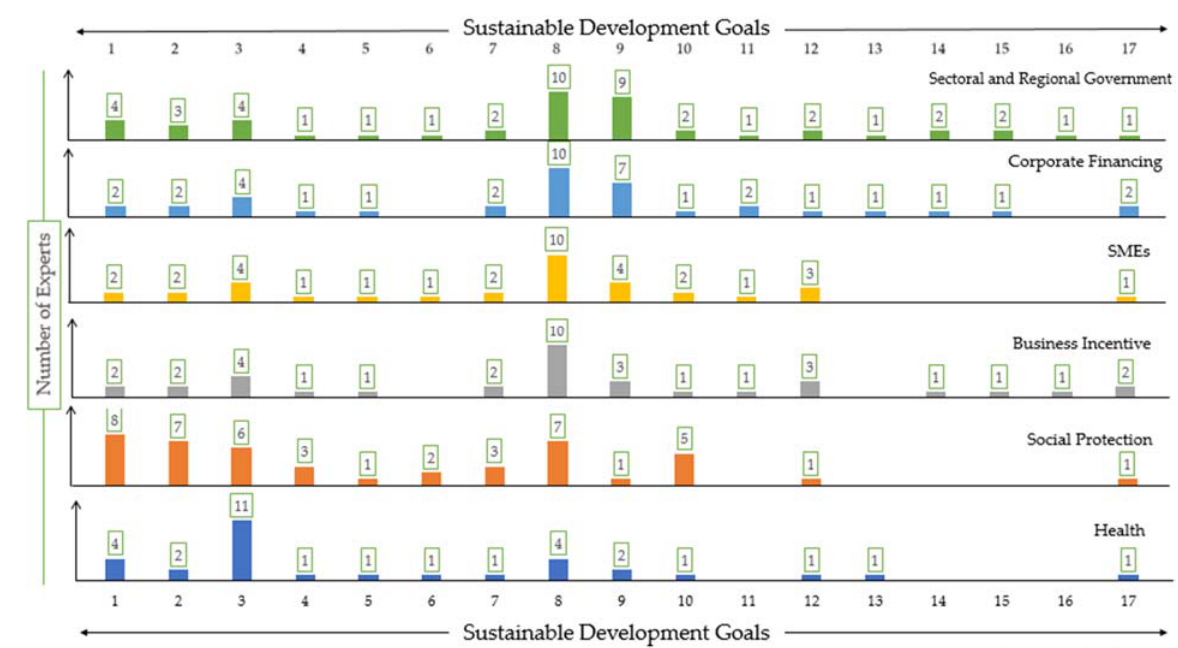
Figure 7. Perceived direct impact of fiscal measures on SDG progress in